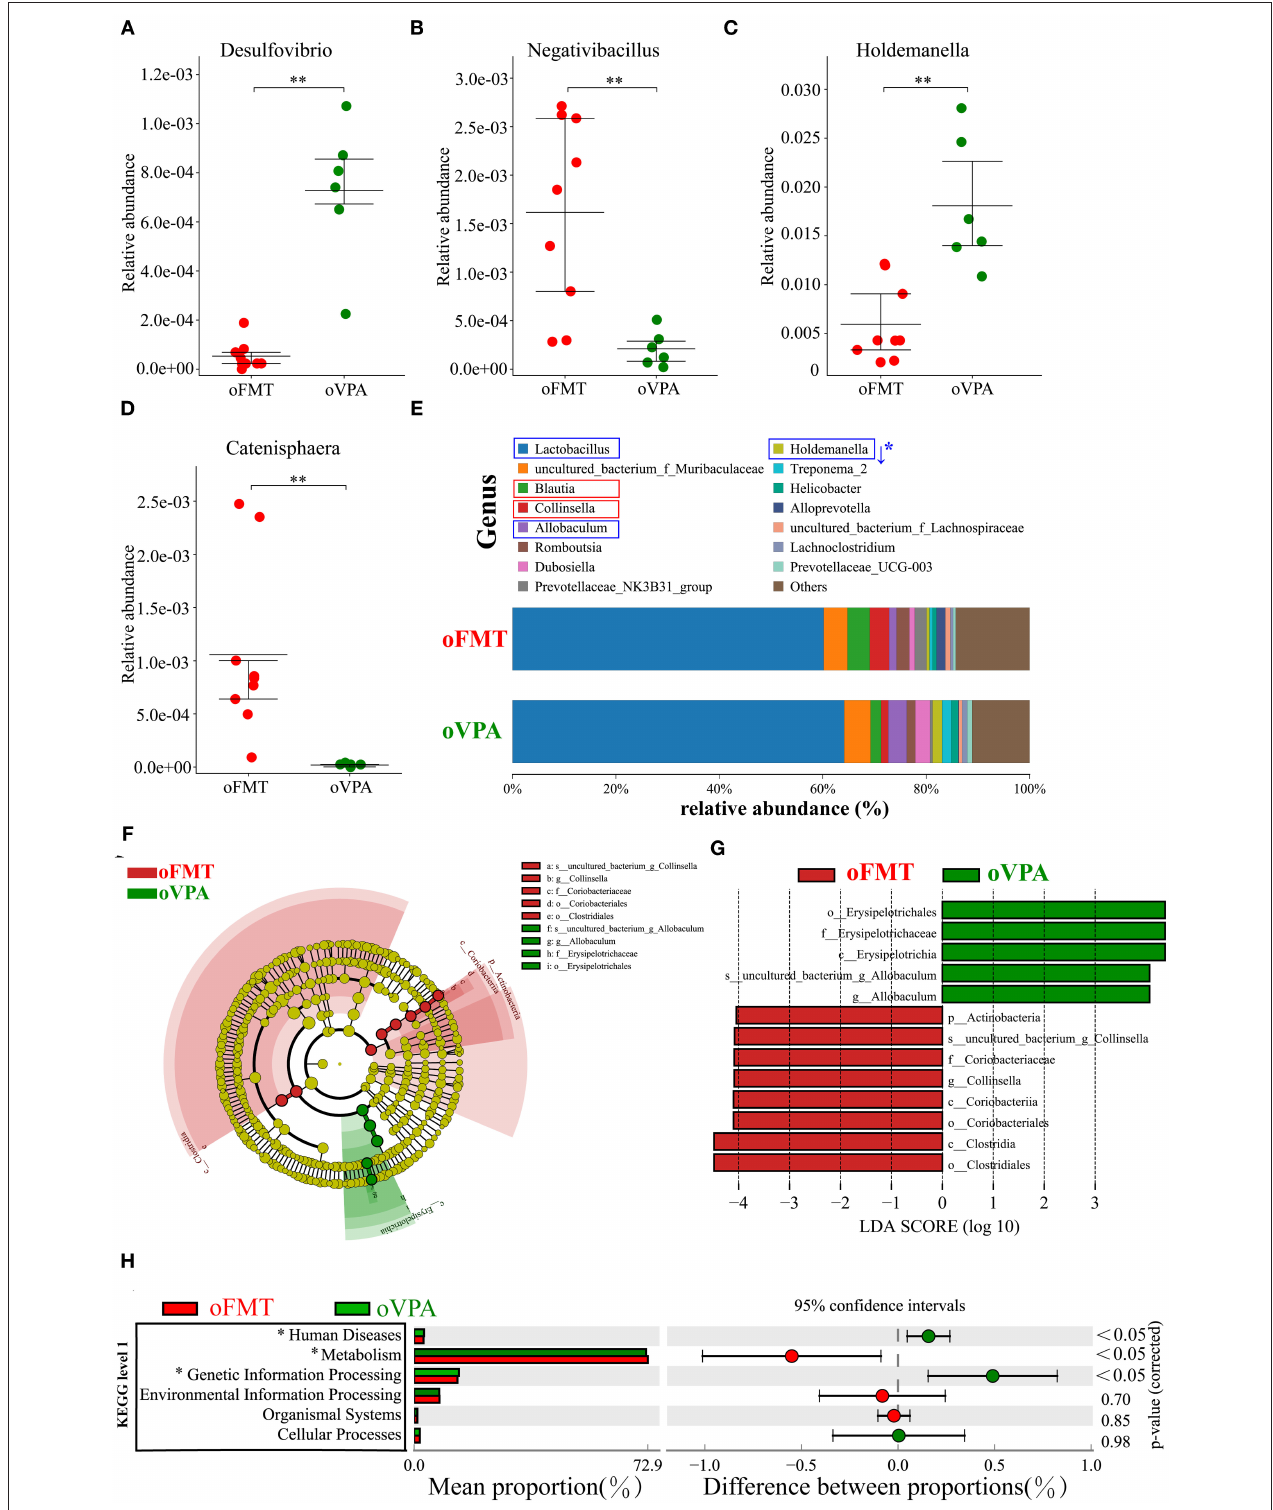
FIGURE 6 | The changes in the gut microbiota composition between oFMT and oVPA according to the 16S rRNA data. Impact of FMT on gut microbiota (cecal and fecal microbiota) in offspring rats (oFMT, n = 9; oVPA, n = 6) (red: oFMT; green: oVPA). ** P < 0.01 compare with the oCON. (A–D) To investigate the differences in microbial community abundance between oFMT and oVPA, t -test was performed on species abundance data at the Genus level by Metastats analysis. Finally, the